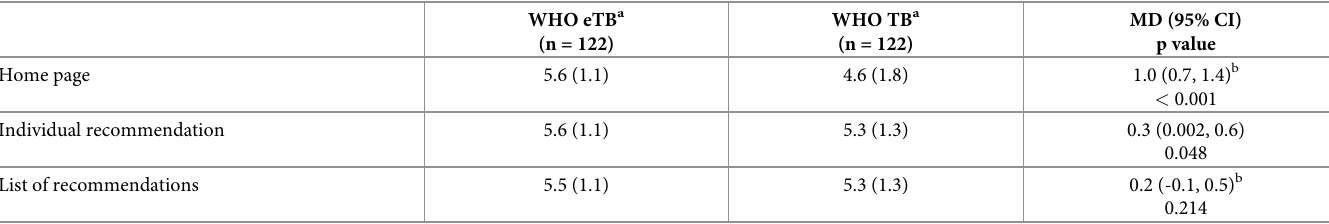
Table 5. Satisfaction with the presentation of platform pages [mean